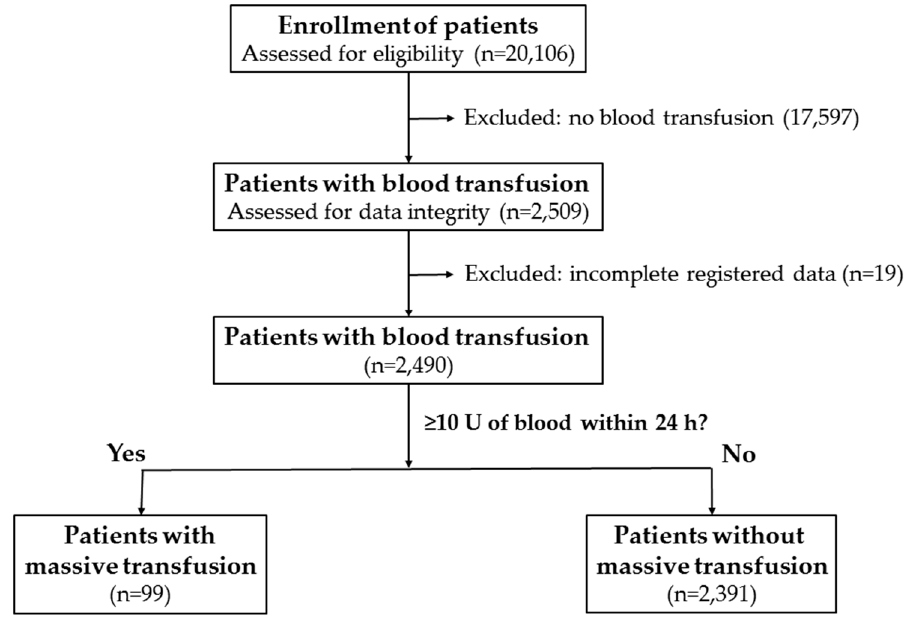
Figure 1. Flow chart of selection of patients with and without massive transfusion.